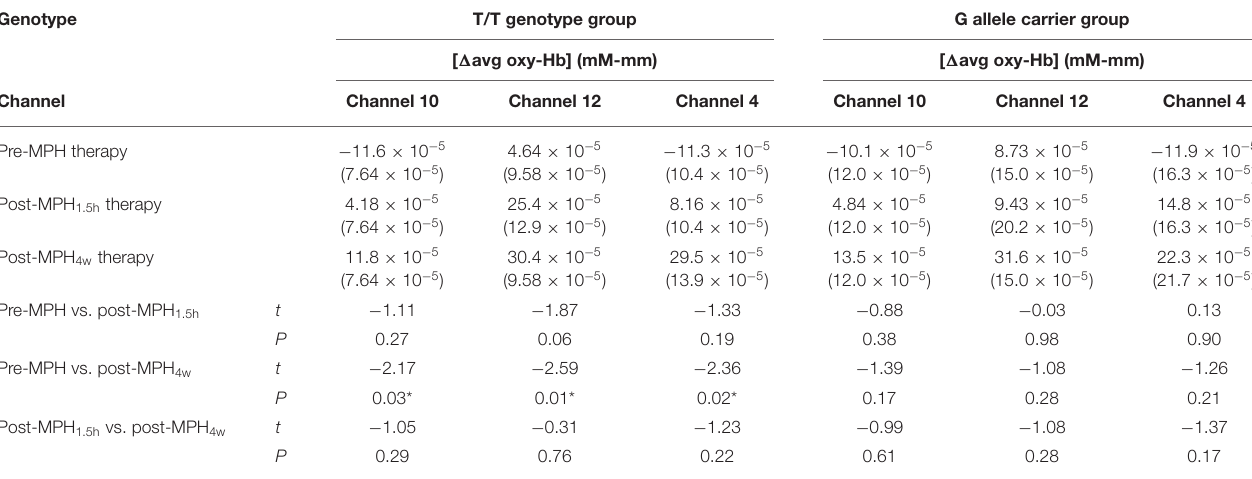
TABLE 3 | Comparison of [ 1 avg oxy-Hb] between pre- and post-MPH treatment conditions in the two groups.